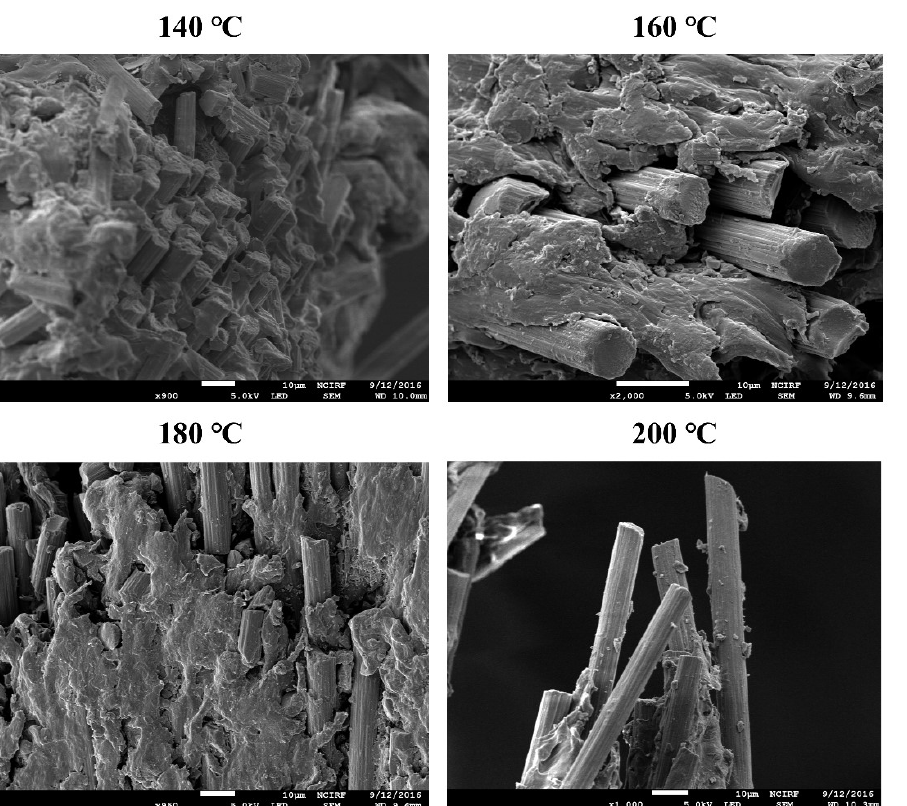
Figure 10. SEM morphology of the fracture surface of CFRPs manufactured at different temperatures (scale bar: 10 μm).